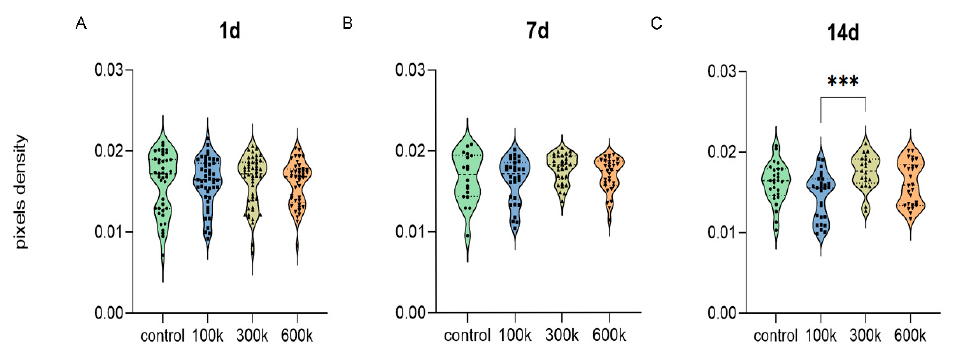
Figure 4. Densitrometric analyses of OCT imaging. HPMEC seeded in LV ECM hydrogels were compared at d1 ( A ), d7 ( B ), and d14 ( C ). Measurements were obtained from three pullbacks over each gel ( n = 5, one way ANOVA comparing gel, *** p < 0.001).